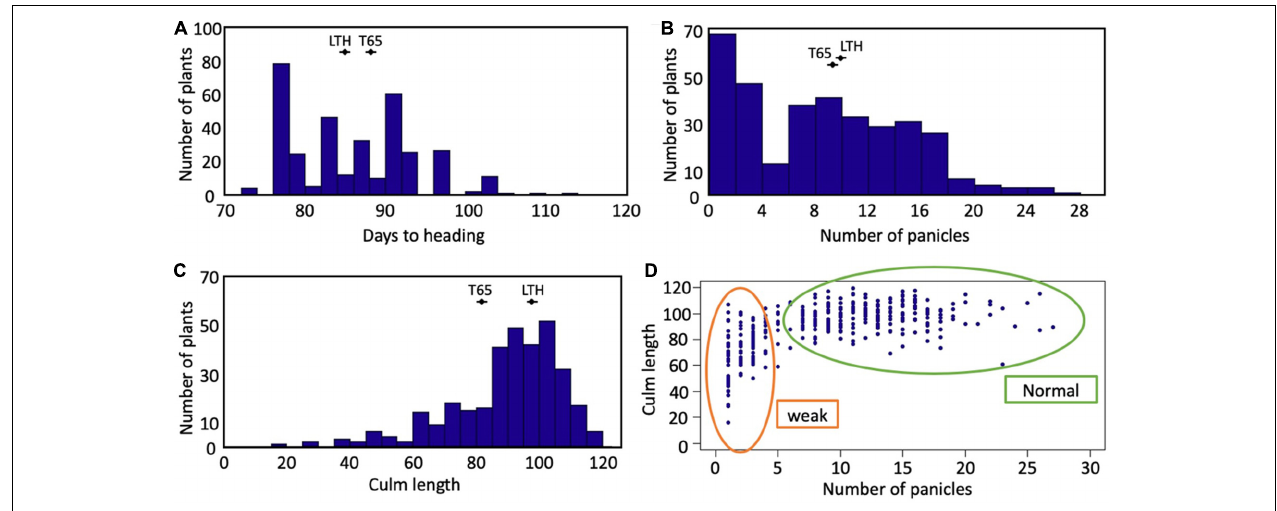
FIGURE 2 | Segregation of traits in F 2 population. Frequency distributions of (A) days to heading, (B) number of panicles, and (C) culm length. The averages of T65 and LTH were shown in each panel. (D) Scatter plot between number of panicles and culm length.